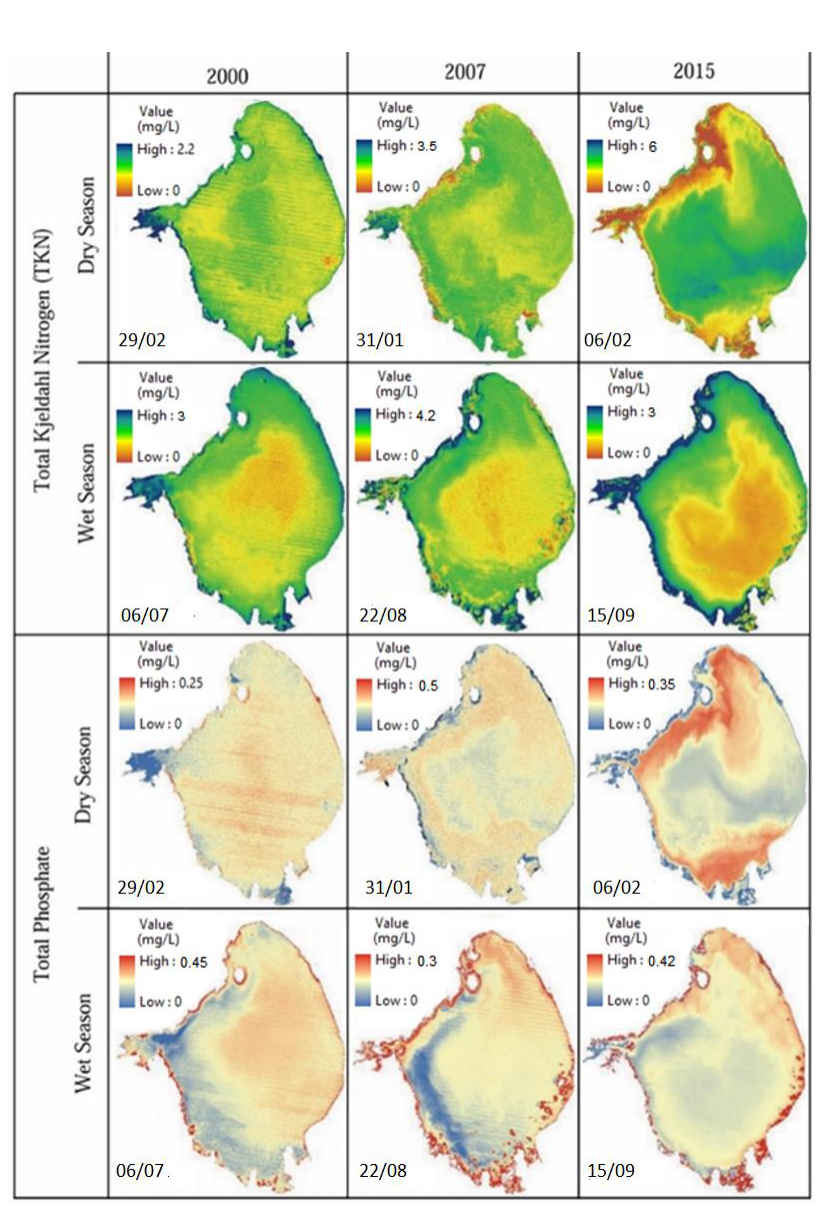
Figure 4. Seasonal and spatial dynamics of TP and TKN in Lake Okeechobee.